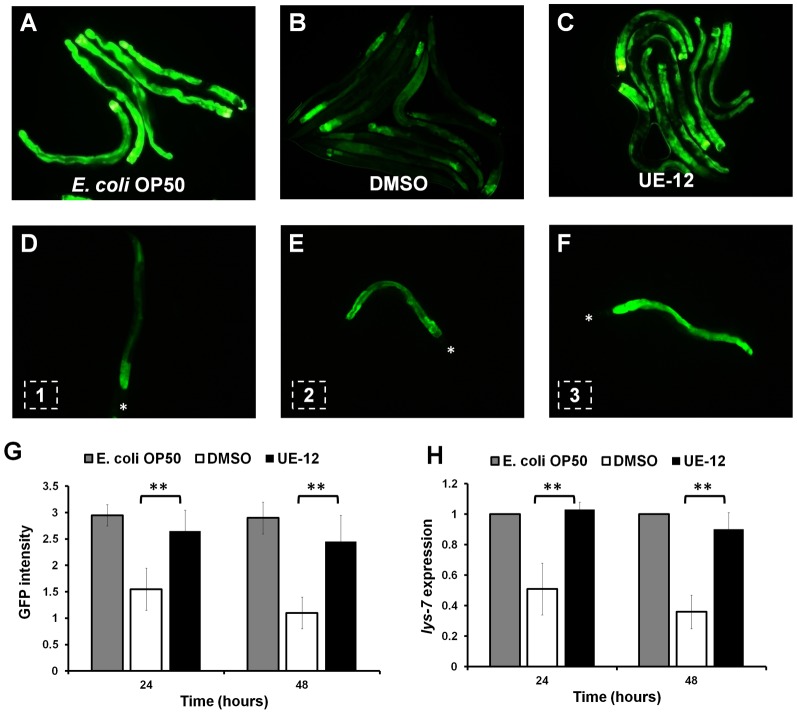
UE-12 replenishes the repressed expression of the lys-7 defense gene.Representative fluorescence micrographs of the population of transgenic plys-7::gfp worms (A) fed on E. coli OP50 (uninfected), (B) infected with S. aureus in the absence of UE-12 (animals were exposed to DMSO only) and (C) infected with S. aureus in the presence of UE-12 (100× magnification). (D,E,F) The criteria used for scoring of plys-7::gfp transgene expression upon S. aureus infection in the presence and absence of extract. Each worm was given a score of 1, 2 or 3 depending on the GFP intensity observed. Asterisks mark the head of the worms. (G) Bars represent the mean ± SD of GFP intensity scores (expressed in arbitrary units) corresponding to the lys-7 expression for each worm (n = 20) according to the criteria presented in panels D, E and F. (H) qRT-PCR analysis of lys-7 mRNA shows significant induction of lys-7 expression in infected animals following treatment with UE-12 at 24 and 48 hpi. **A significant difference between untreated (DMSO) and UE-12-treated worms (p<0.001).